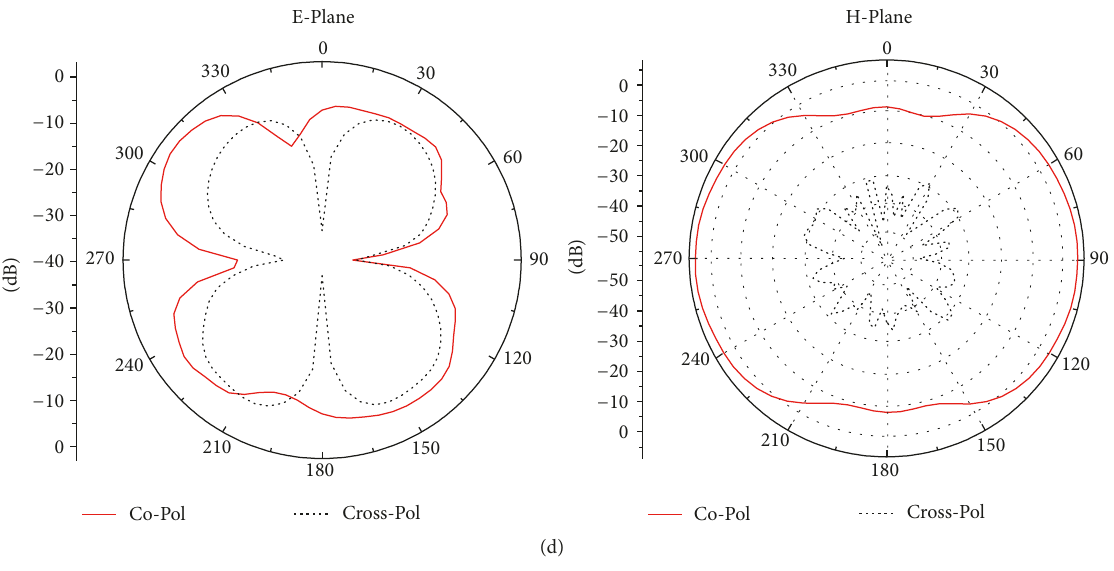
Figure 8: E-plane and H-plane radiation patterns at (a) 1.6GHz, (b) 2.6 GHz, (c) 3.7 GHz, and (d) 5.3 GHz.